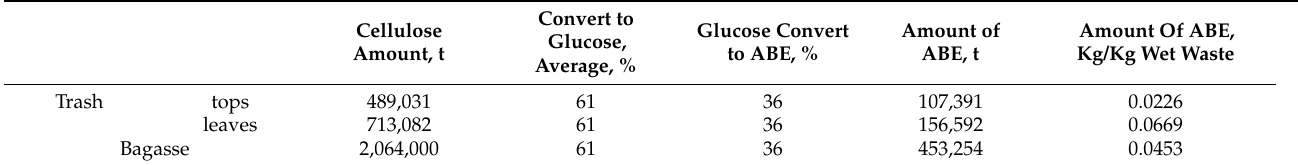
Table 16. Potential amount of ABE produced from trash and bagasse.